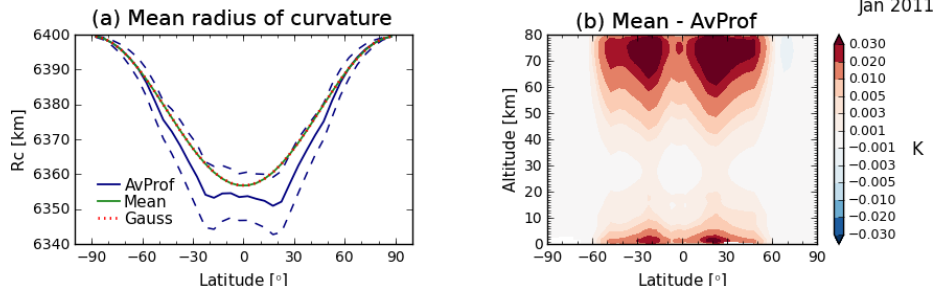
Figure 1. (a) Comparing different implementations of the mean radius of curvature R c , analyzed for a 5 ◦ zonal COSMIC climatology from January 2011. (b) Dry temperature difference, comparing the implementation of R c using Eq. (3) (mean) to Eq. (2) (AvProf). Table 1. Data sets from the COSMIC mission, always for monthly 5 ◦ zonal climatologies of the dry atmosphere. Processing Inversion L1b bending angle Parameters Extrapolation